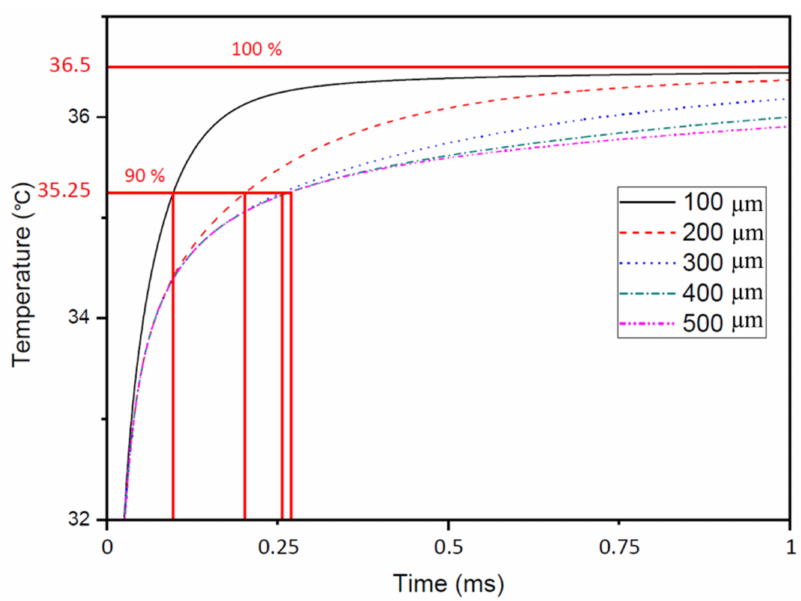
Figure 5. Simulated temperature variation at point A1 of the sensing layer for different substrate thicknesses (100, 200, 300, 400 and 500 µ m) and a temperature boundary condition of 36.5 ◦ C.